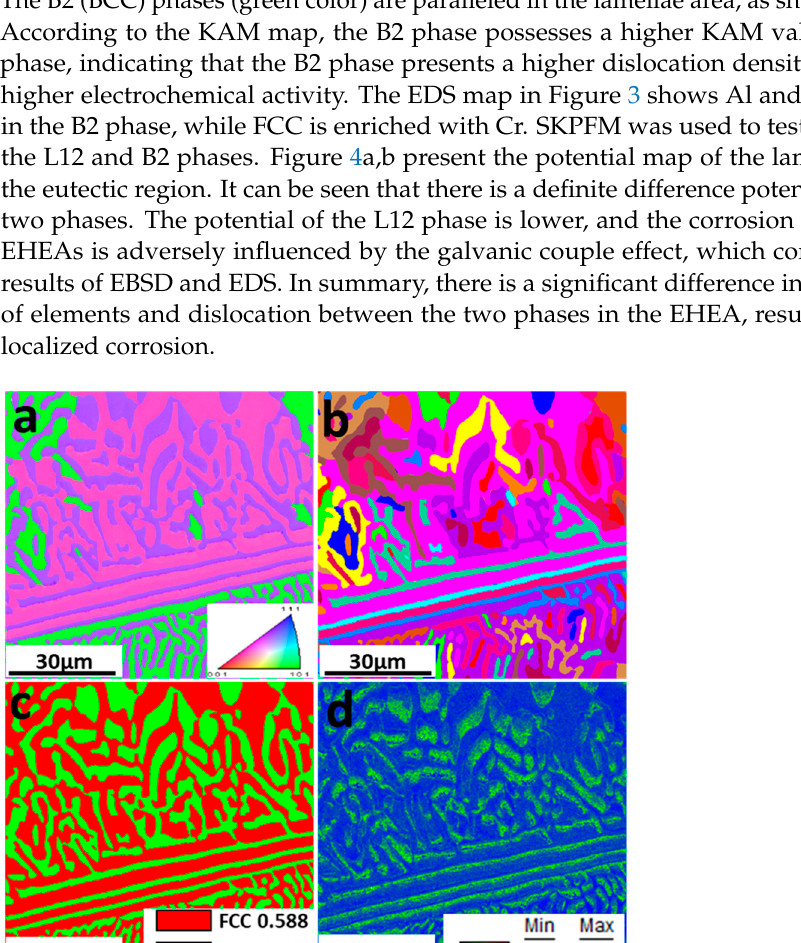
Figure 3. EDS of AlCoCrFeNi 2.1 .